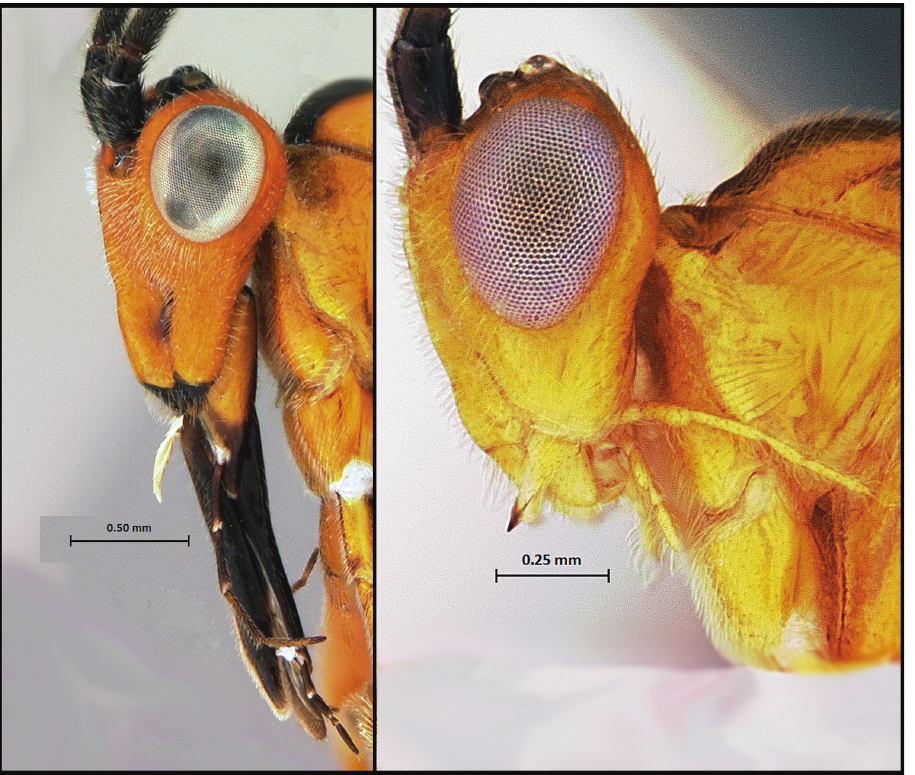
Figure 1. Mouthparts of Camptothlipsis lingualongis , a member of the species-group Lingualongis (left) compared with the mouthparts of a representative of the rest of the genus